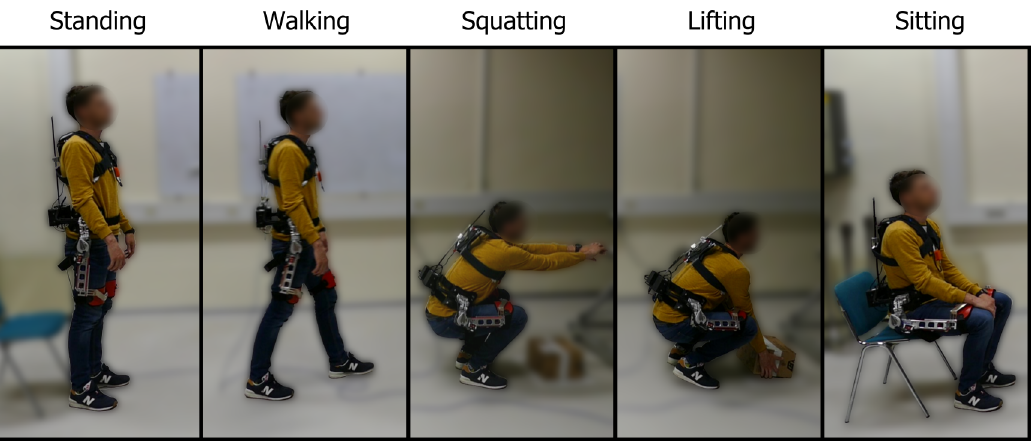
Figure 2. Example of performed tasks during the